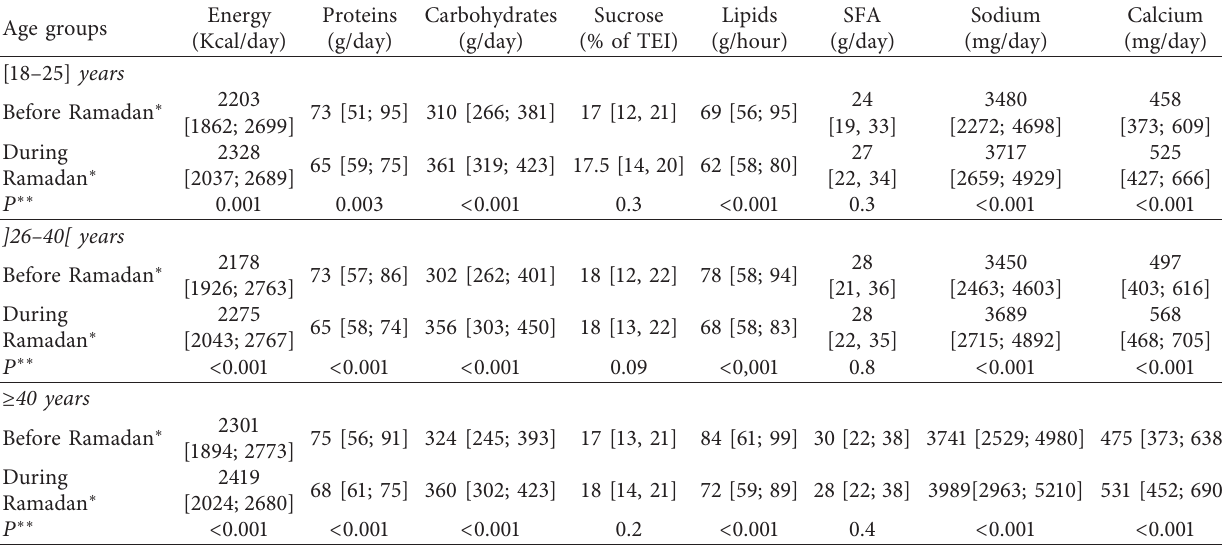
Table 5: Comparison of nutritional intake before and during Ramadan according to age groups ( n � 340). Age groups